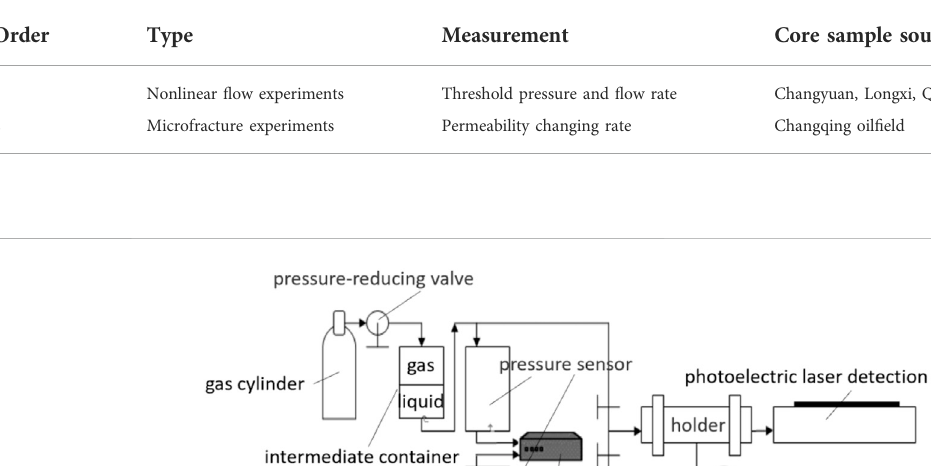
TABLE 1 Details of nonlinear fl ow and microfracture experiments.